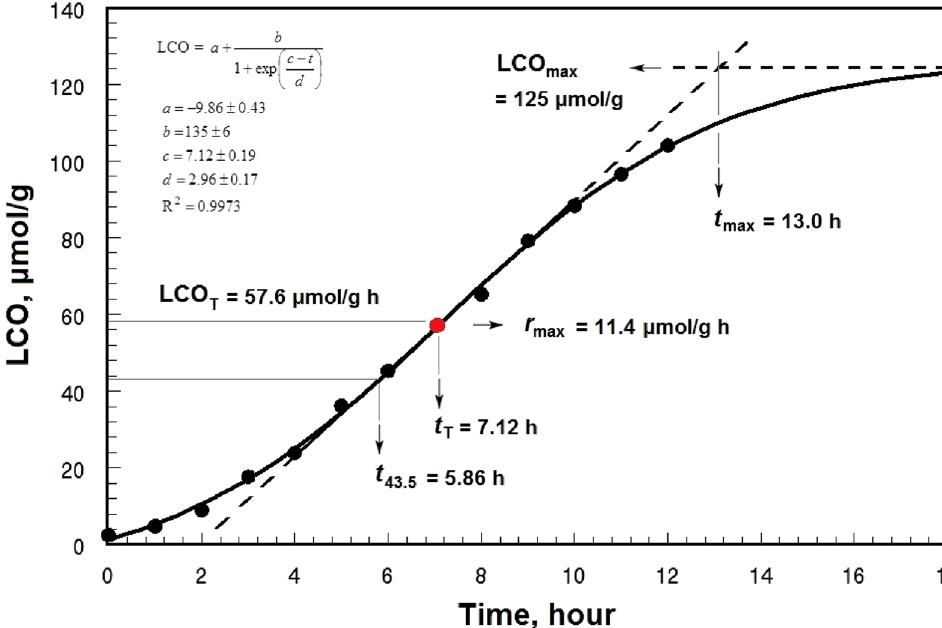
Figure 2. Kinetic curve of the accumulation of lipid-peroxidation carbonyls (LCO) during peroxidation of the sunflower oil at 80 °C, and the kinetic parameters from the sigmoidal equation fitted on the whole range of the data points. t 43.5 : the time required to reach a LCO content of 43.5 μmol g −1 ; LCO T and t T : the coordinates of the turning point at which the rate of LCO accumulation reaches the maximum value r max ; LCO max : the maximum concentration of LCO attained during the course of lipid peroxidation; t max : the time required to reach LCO max